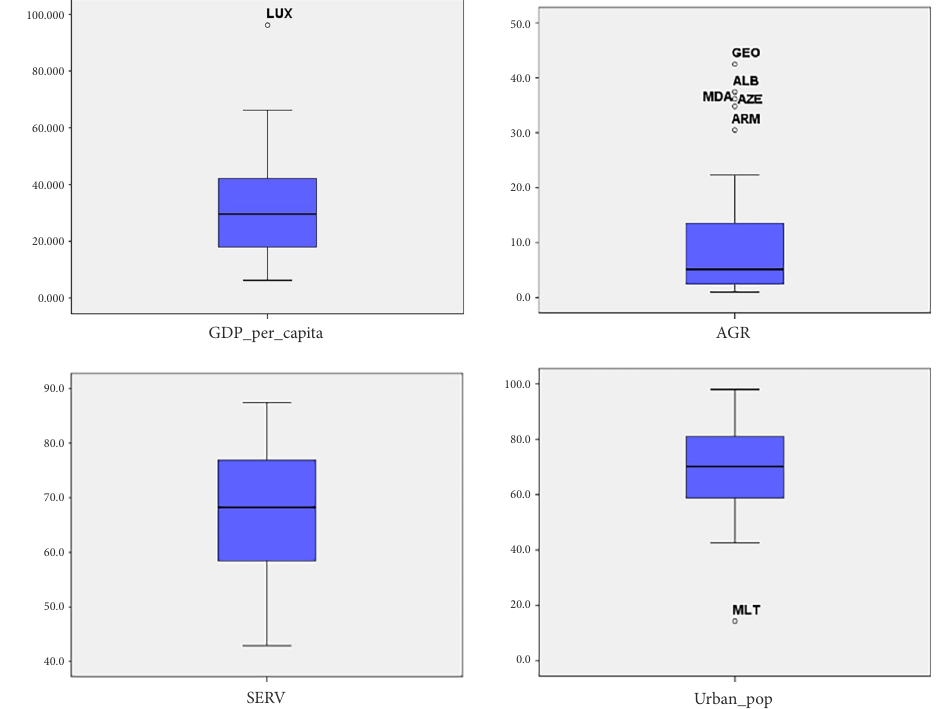
Figure 4. Box-plots for development and connectivity indicators (source: authors’ computation using IBM SPSS Statistics